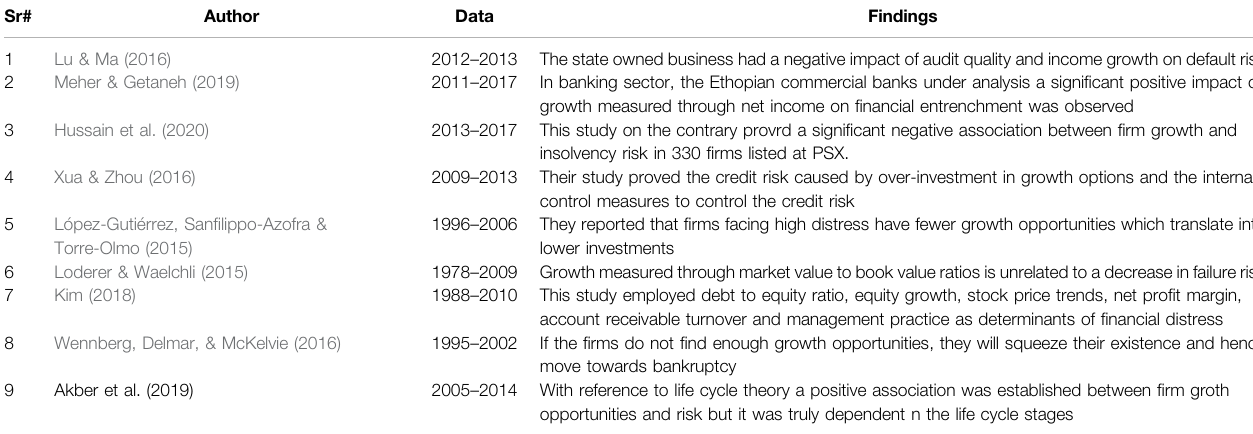
TABLE 1 | Evidence on heterogenous impact of fi rm growth on insolvency